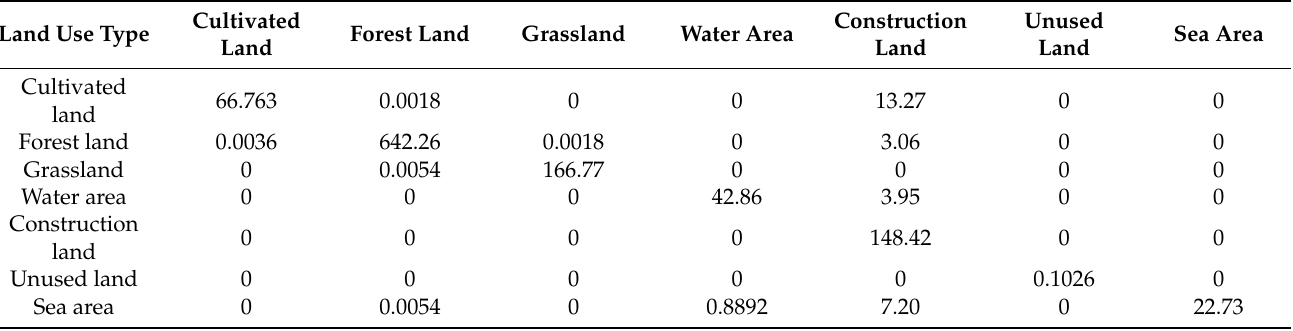
Table 4. Land Use Transformation Matrix, 1980–1990 (km 2